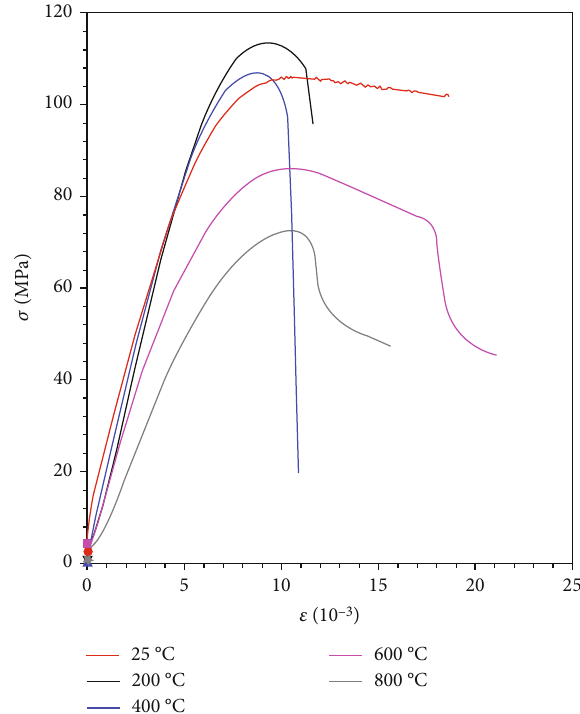
Figure 6: Stress-strain curves of tight sandstones after synthetic formation water